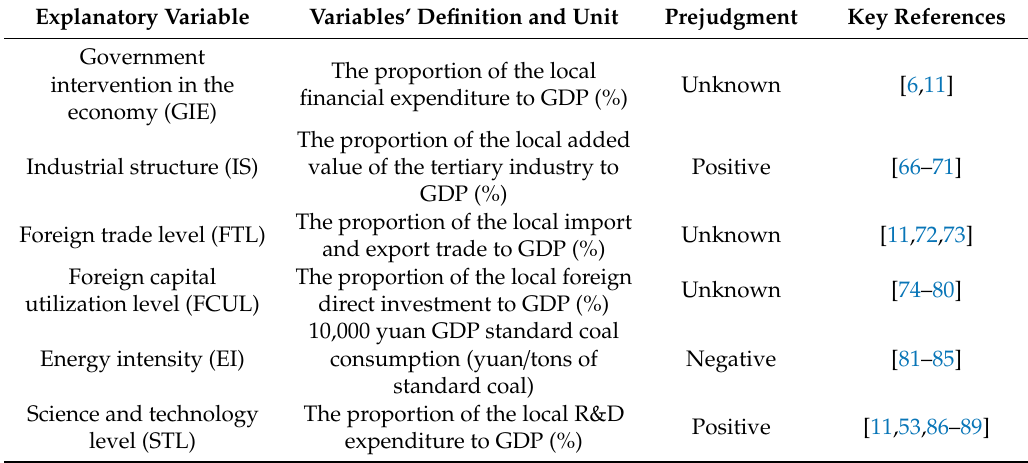
Table 5. Influencing factors.